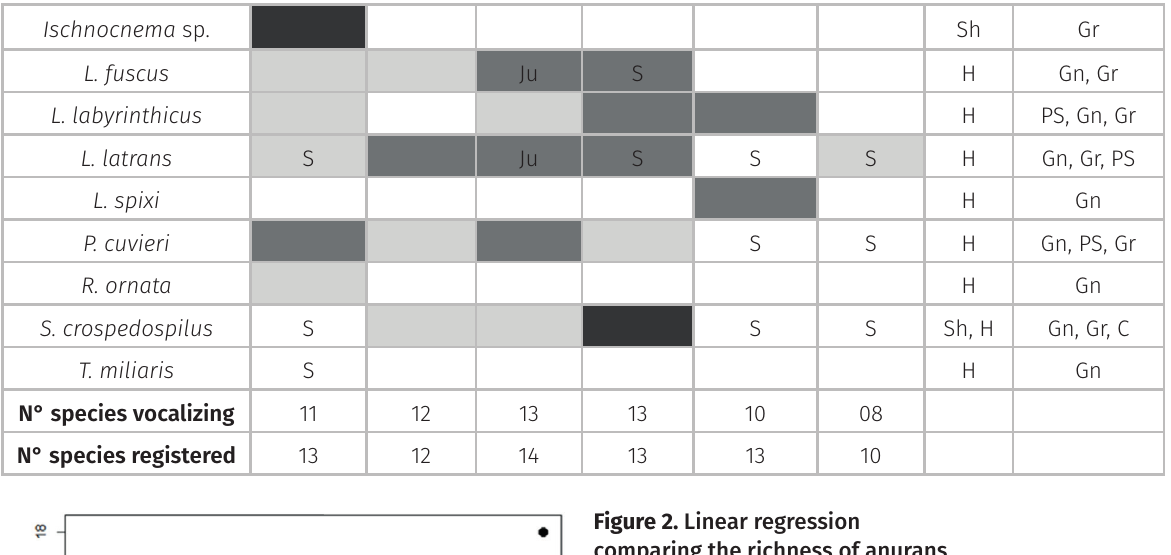
Figure 2. Linear regression comparing the richness of anurans in breeding activity with rainfall in the rainy season (October to March) between 2013–14 and 2014–15. Black dots (each point represents one month of study).